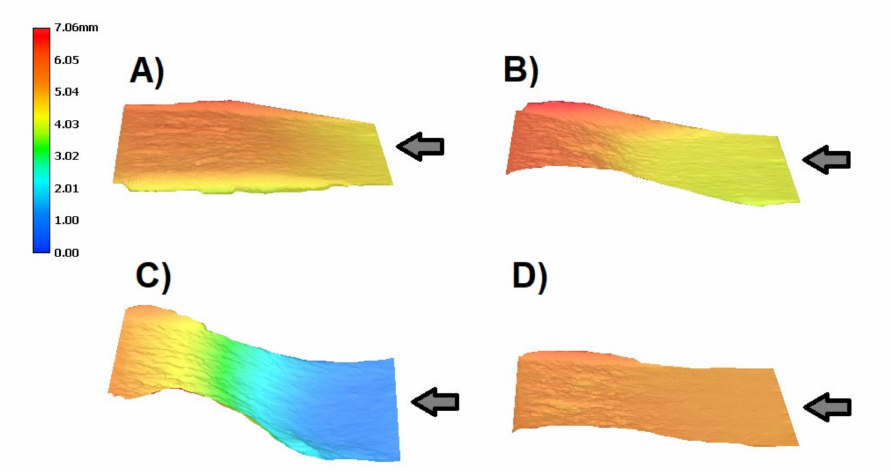
Figure 8. Three-dimensional models of crack propagation surface for all specimens, arrows directly show crack propagation: ( A )—topology 1; ( B )—topology 2; ( C )—topology 3; ( D )—topology